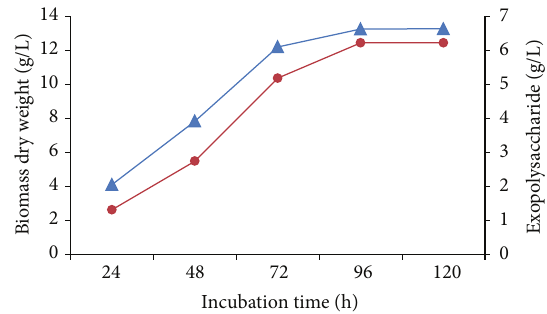
Figure 1: Time course of batch culture of Bacillus subtilis MTCC10619. Blue triangles: cell dry weight (g/L) and red bullets: bioflocculant production